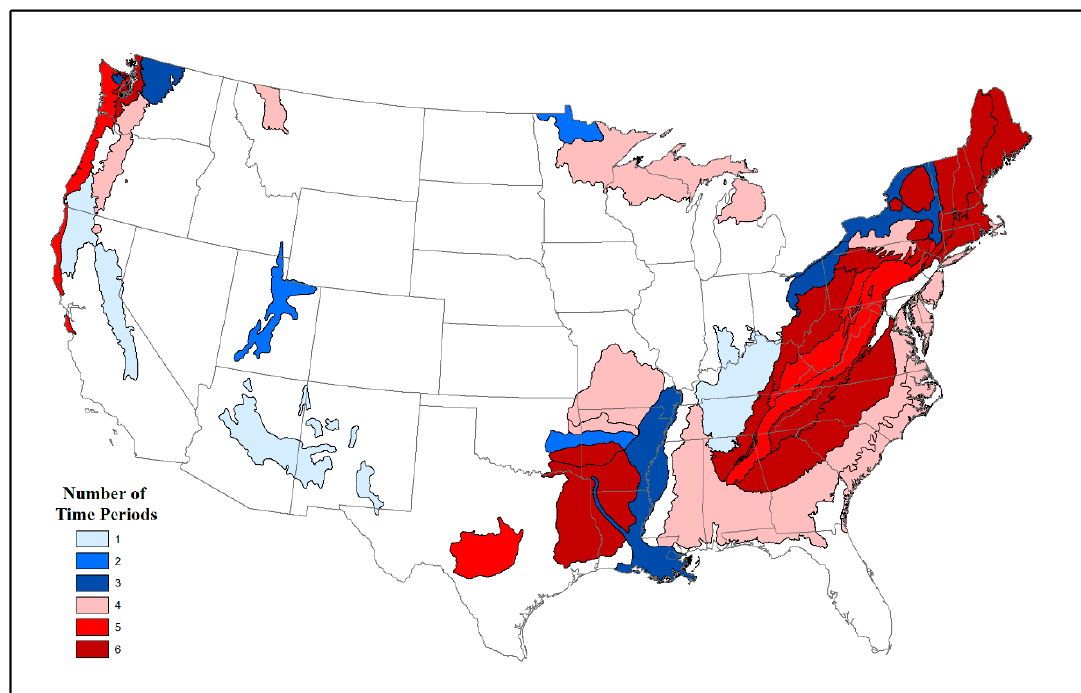
Figure 3. Ecoregions with forest as a substantial source of new development in any and all time intervals. Ecoregions where at least 40% of new developed land cover came from